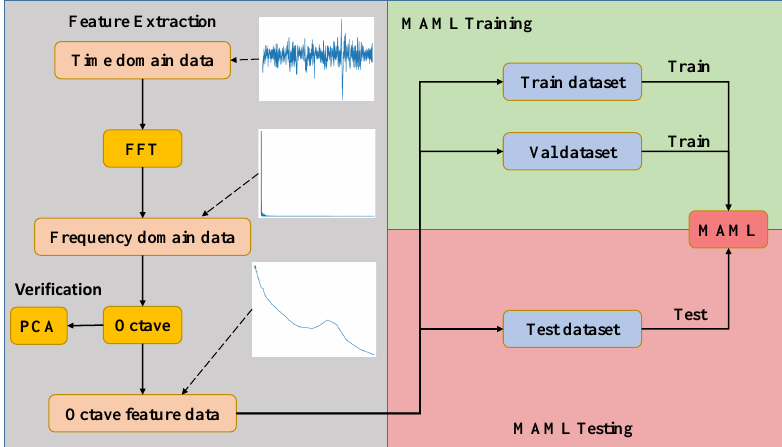
Figure 2. Workflow of the MAML-based acoustic defect detection